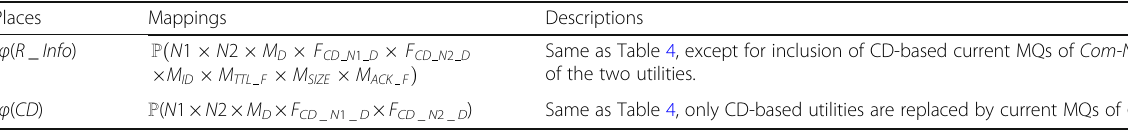
Table 6 Places and mappings of FAR Places Mappings